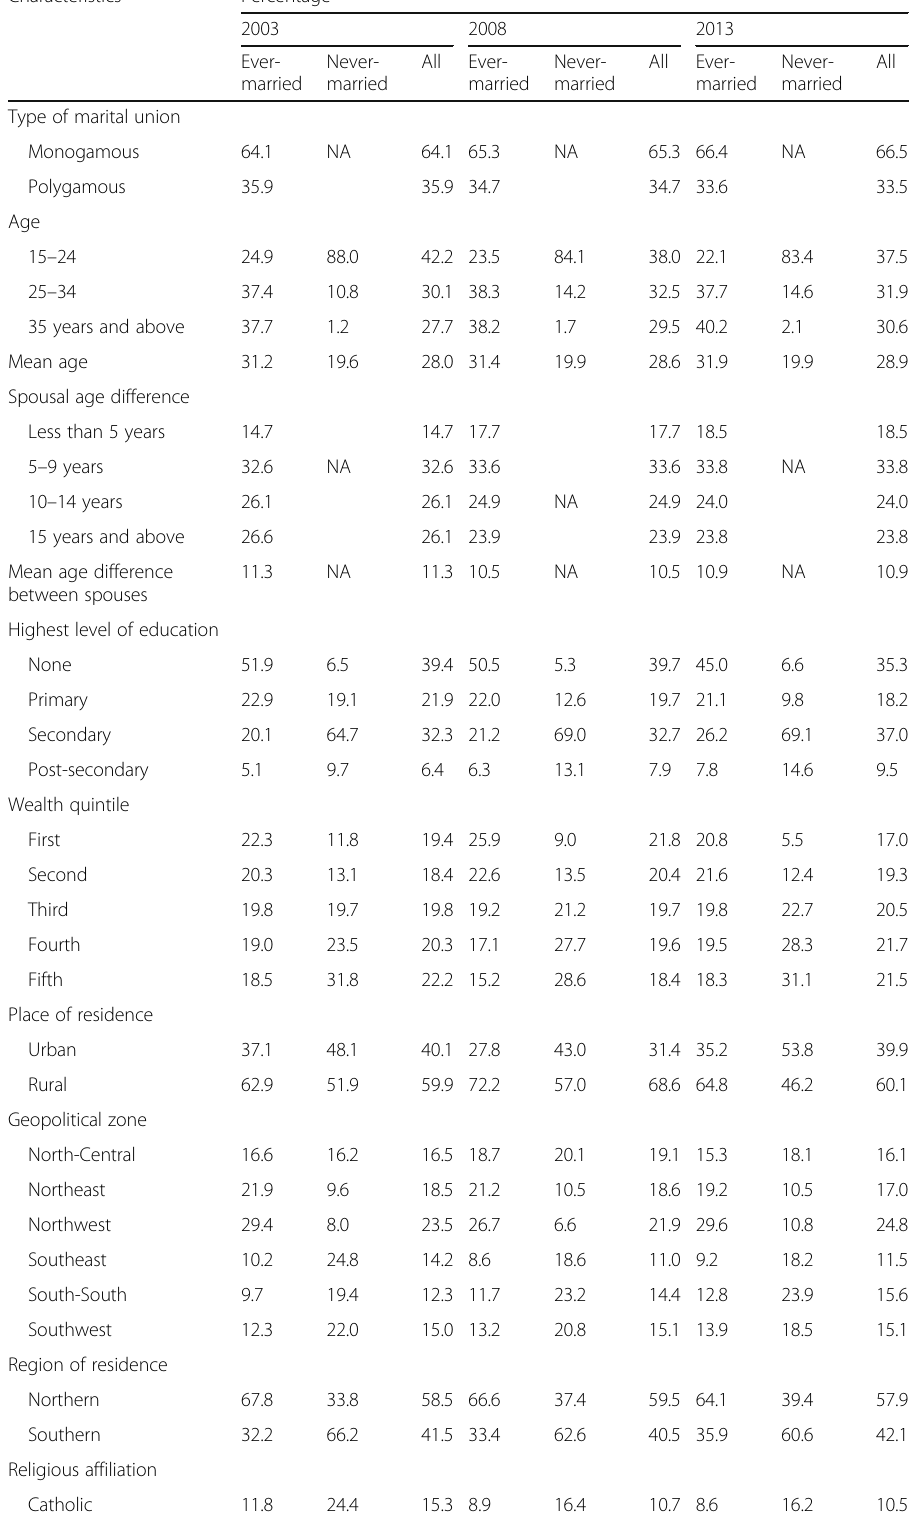
Table 1 Respondents ’ distribution according to demographic and socioeconomic characteristics, 2003 – 2013 NDHS